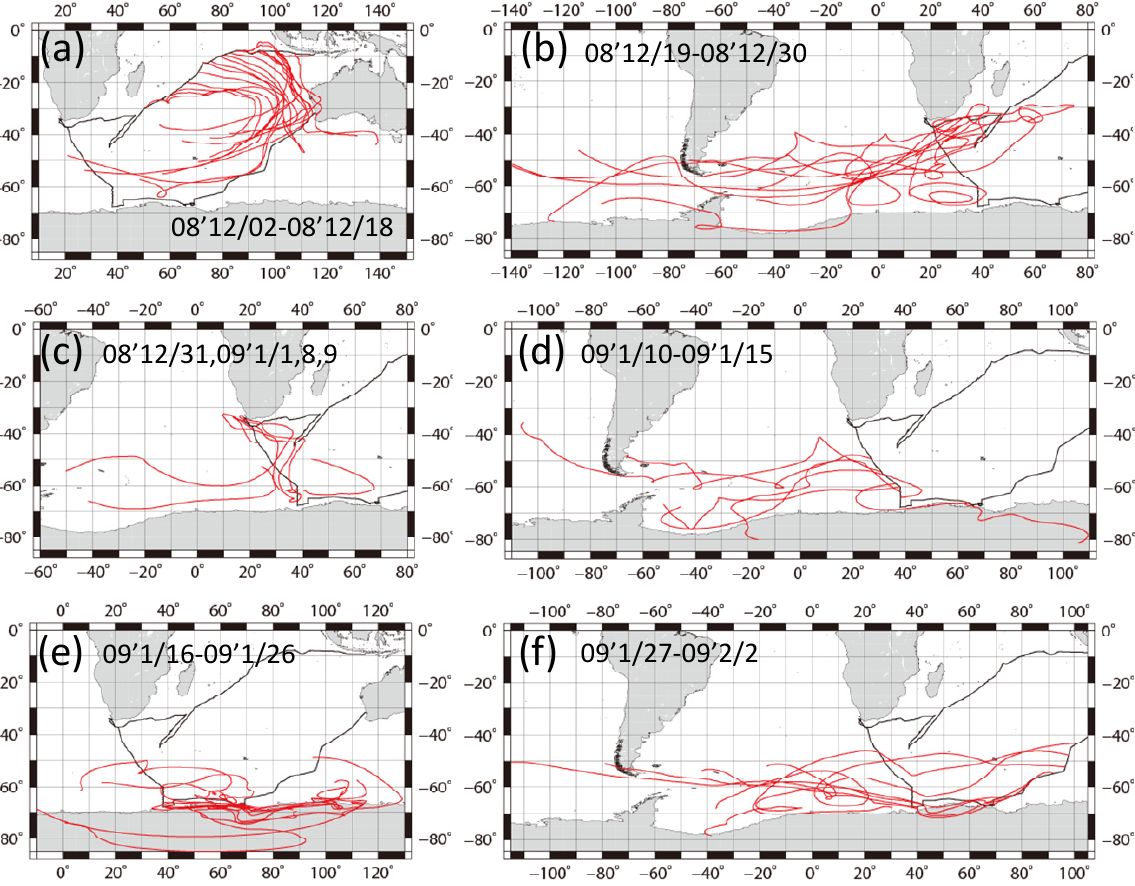
Figure 6. The 10-day backward air mass trajectories along the ship tracks. Calculations started from 500ma.s.l. above the site every day at noon, local time. Red lines show backward air mass trajectories. Black lines show ship tracks.